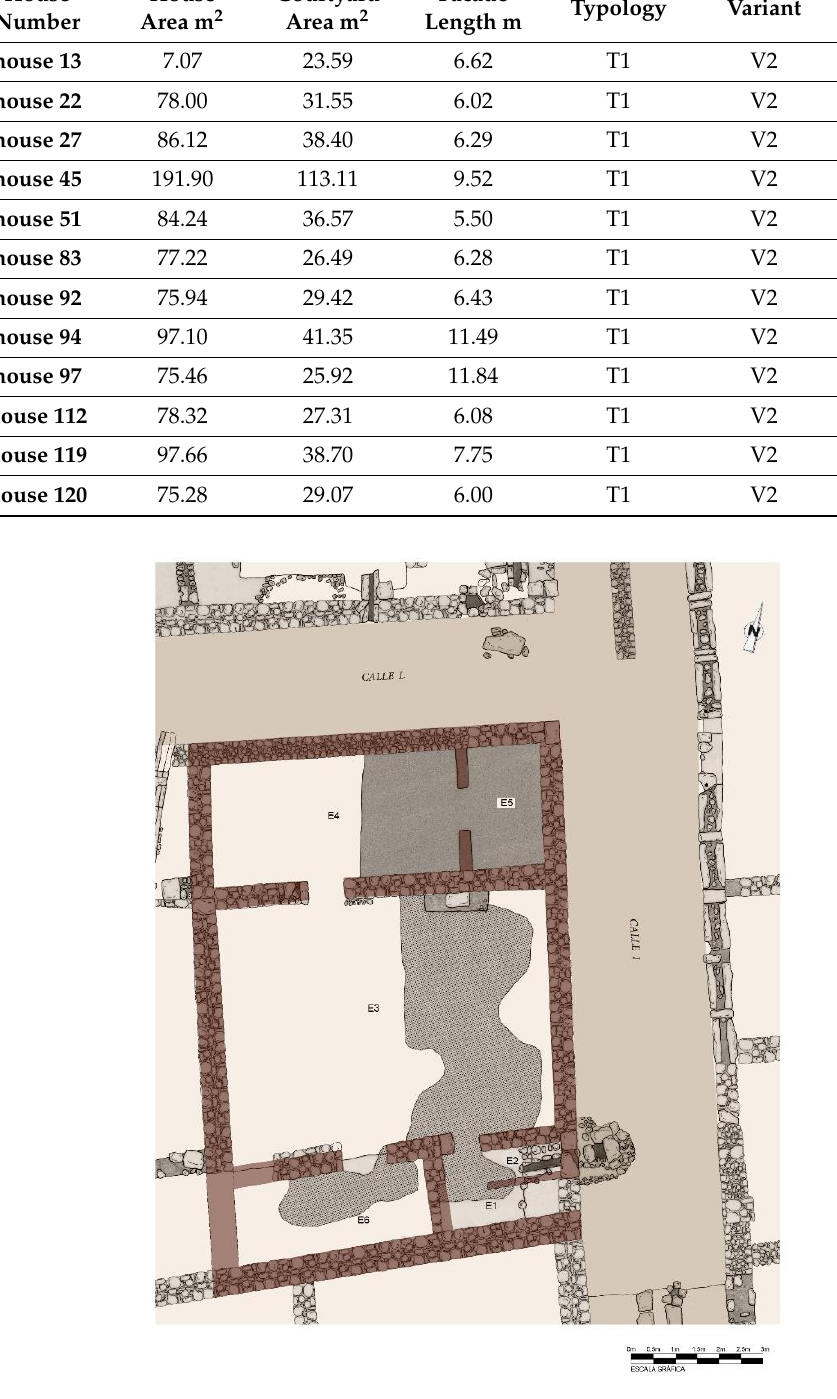
Figure 16. House 51. In the northern bay, the alcove and the living room can be distinguished.